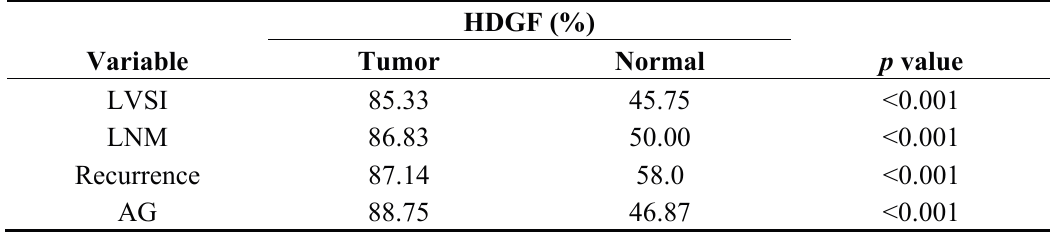
Table 1. Immunohistochemical results. LVSI, lymph-vascular space invasion; LNM, lymph node metastasis; AG, advanced